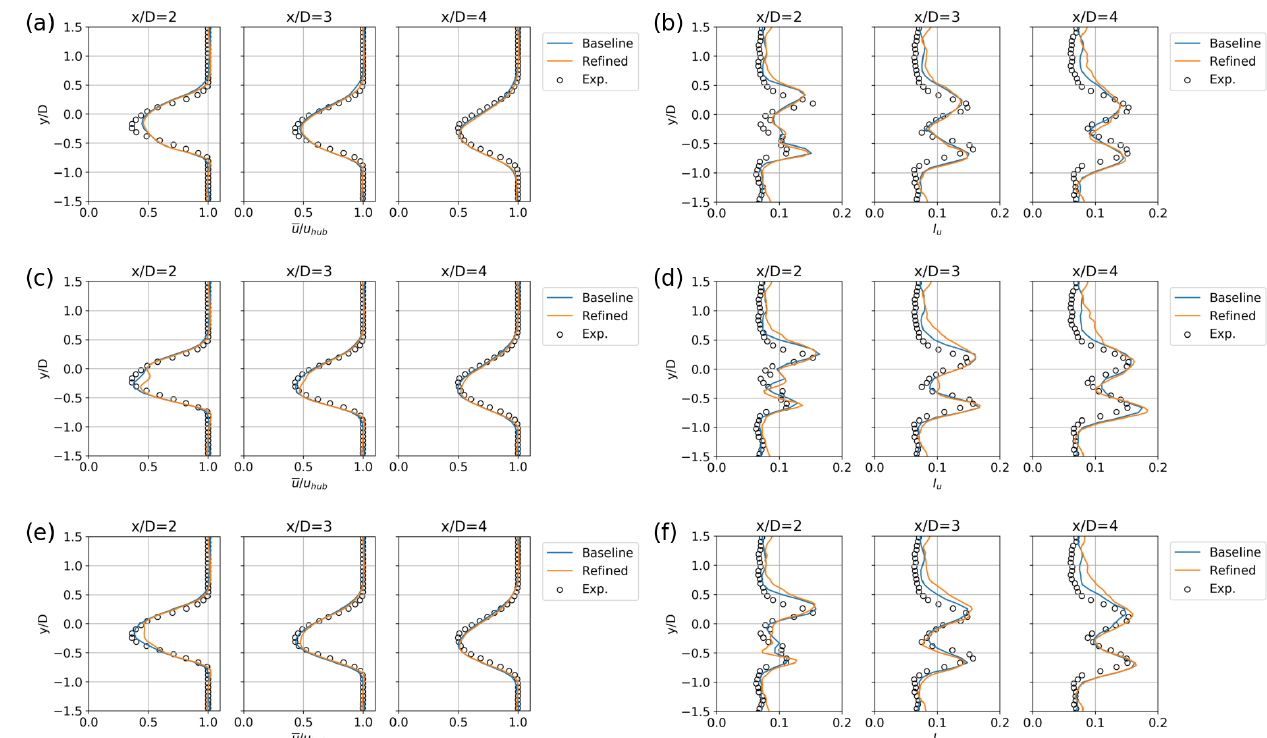
Figure A1. Profiles of the normalised streamwise mean velocity (a, c, e) and turbulence intensity (b, d, f) in the x − y plane at the hub height, obtained from the wind-tunnel experiments and the LES at different grid resolutions. (a) and (b) : the ADM-std; (c) and (d) : the ADM-BE; (e) and (f) : the ALM. The yaw angle of the wind turbine is 25 ◦ .